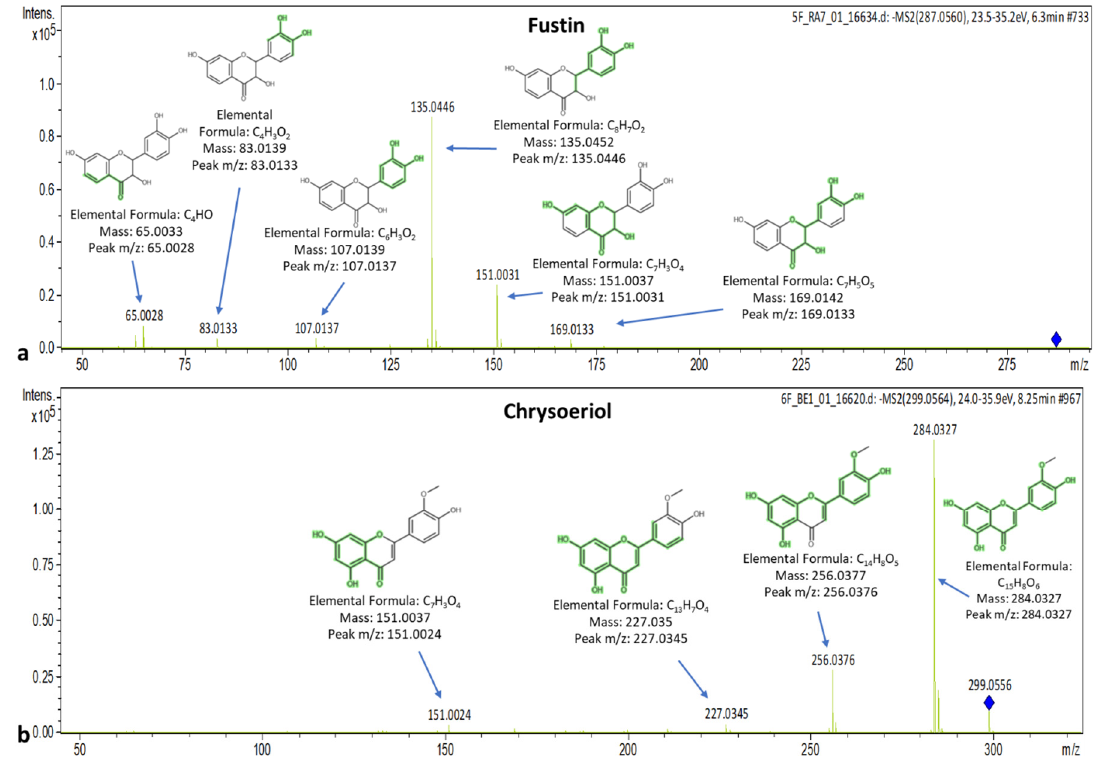
Figure 9. Spectra and MS/MS fragments of ( a ) fustin and ( b ) chrysoeriol.